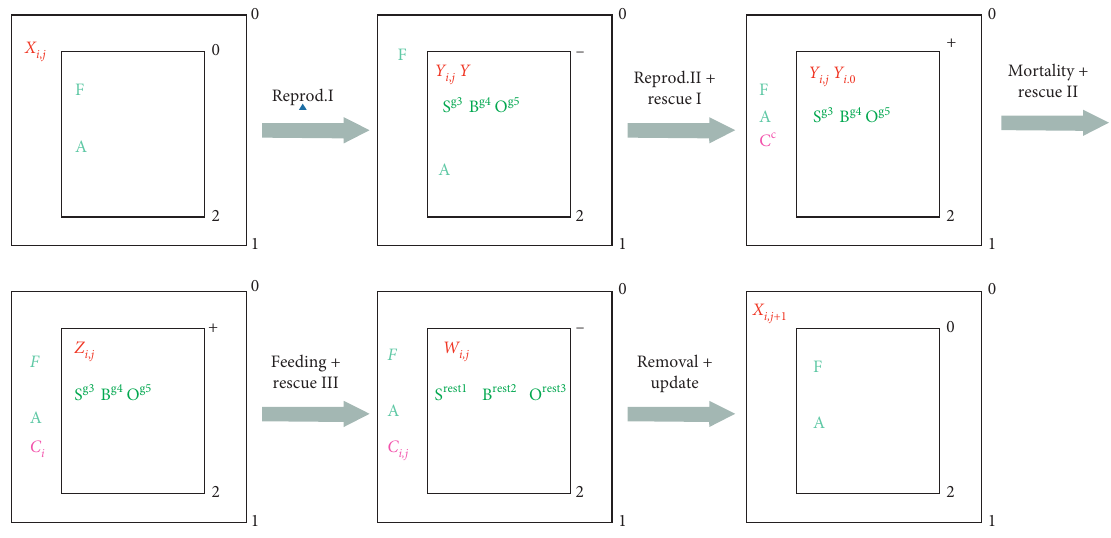
Figure 3: Evolution patterns of a simulation